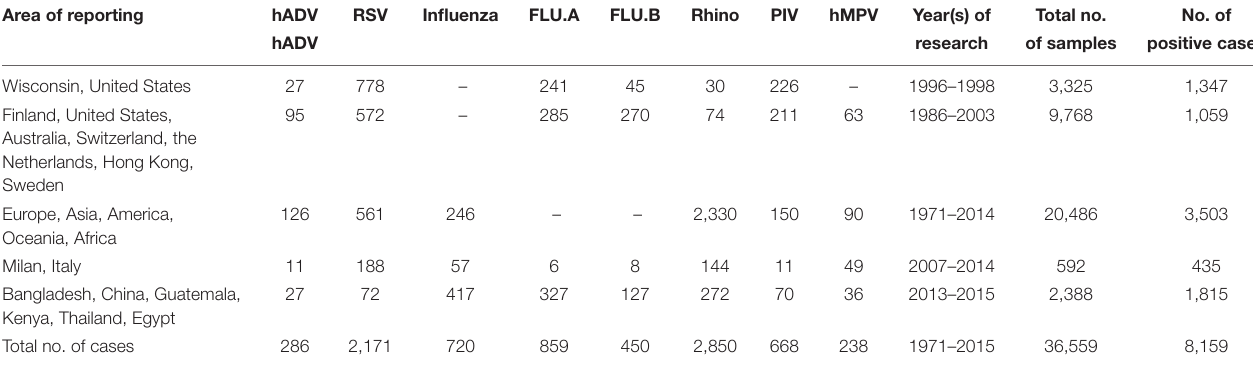
TABLE 3 | Representative studies from the rest of the world to compare the scenario of viral disease prevalence in India. Area of reporting hADV RSV